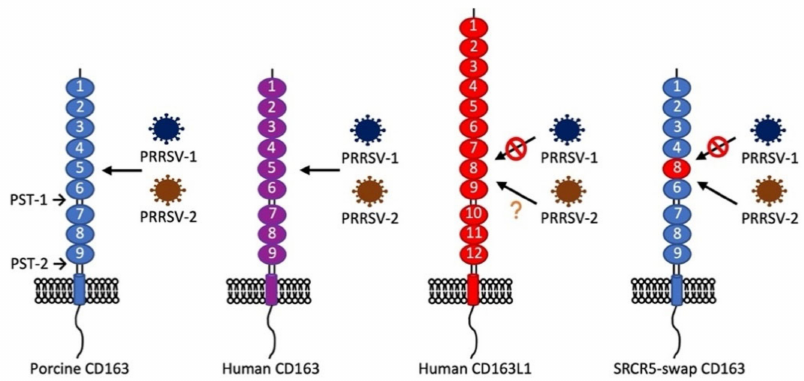
Figure 1. Structure of porcine CD163, human CD163, human CD163L1, and their supportability for porcine reproductive and respiratory syndrome virus (PRRSV)-1 or PRRSV-2 infection. Porcine CD163 supports PRRSV-1 and PRRSV-2 infections, whereas human CD163 supports PRRSV-2 infection [32]. Whether human CD163 supports PRRSV-1 infection is unknown. Human CD163L1 is a homolog of CD163 but does not support PRRSV-1 infection [94]. The cysteine-rich scavenger receptor superfamily (SRCR)5-swap CD163 was made by replacing the SRCR5 domain of porcine CD163 with the SRCR8 domain of human CD163L1. Expression of SRCR5-swap CD163 in HEK293T (human embryonic kidney cells) and porcine alveolar macrophages (PAMs) does not confer the permissiveness of PRRSV- 1 [94,98]. However, SRCR5-swap CD163 in PAMs supports most PRRSV-2 strains infection [98], except PRRSV-2 JXA1